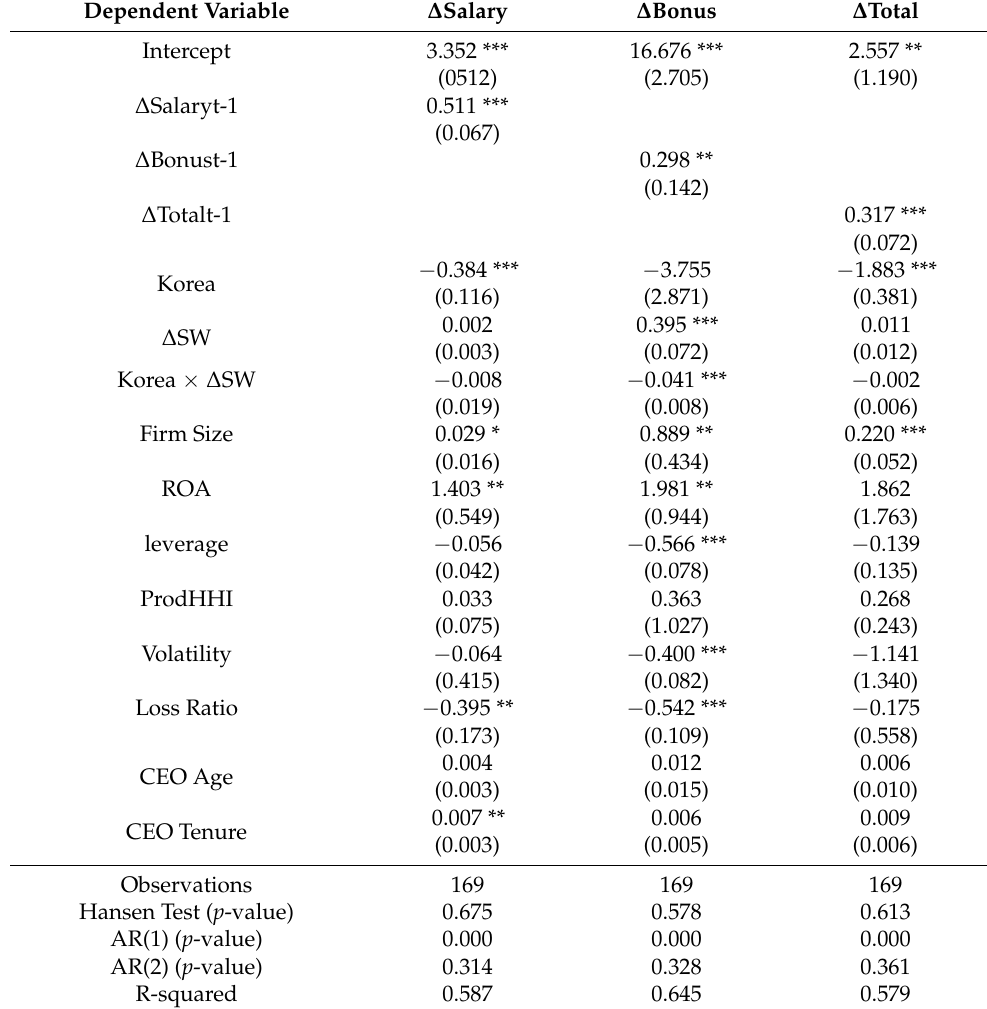
Table 10. Comparison of Compensation-performance Sensitivity using system